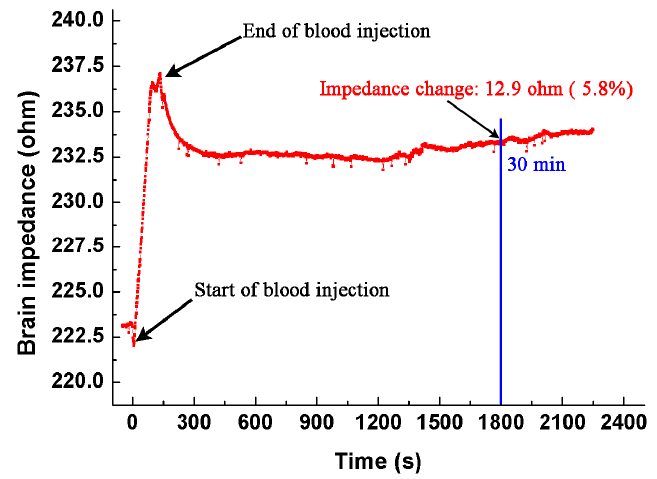
Figure 8. The brain impedance during the whole procedure (from the start of blood injection to 30 min